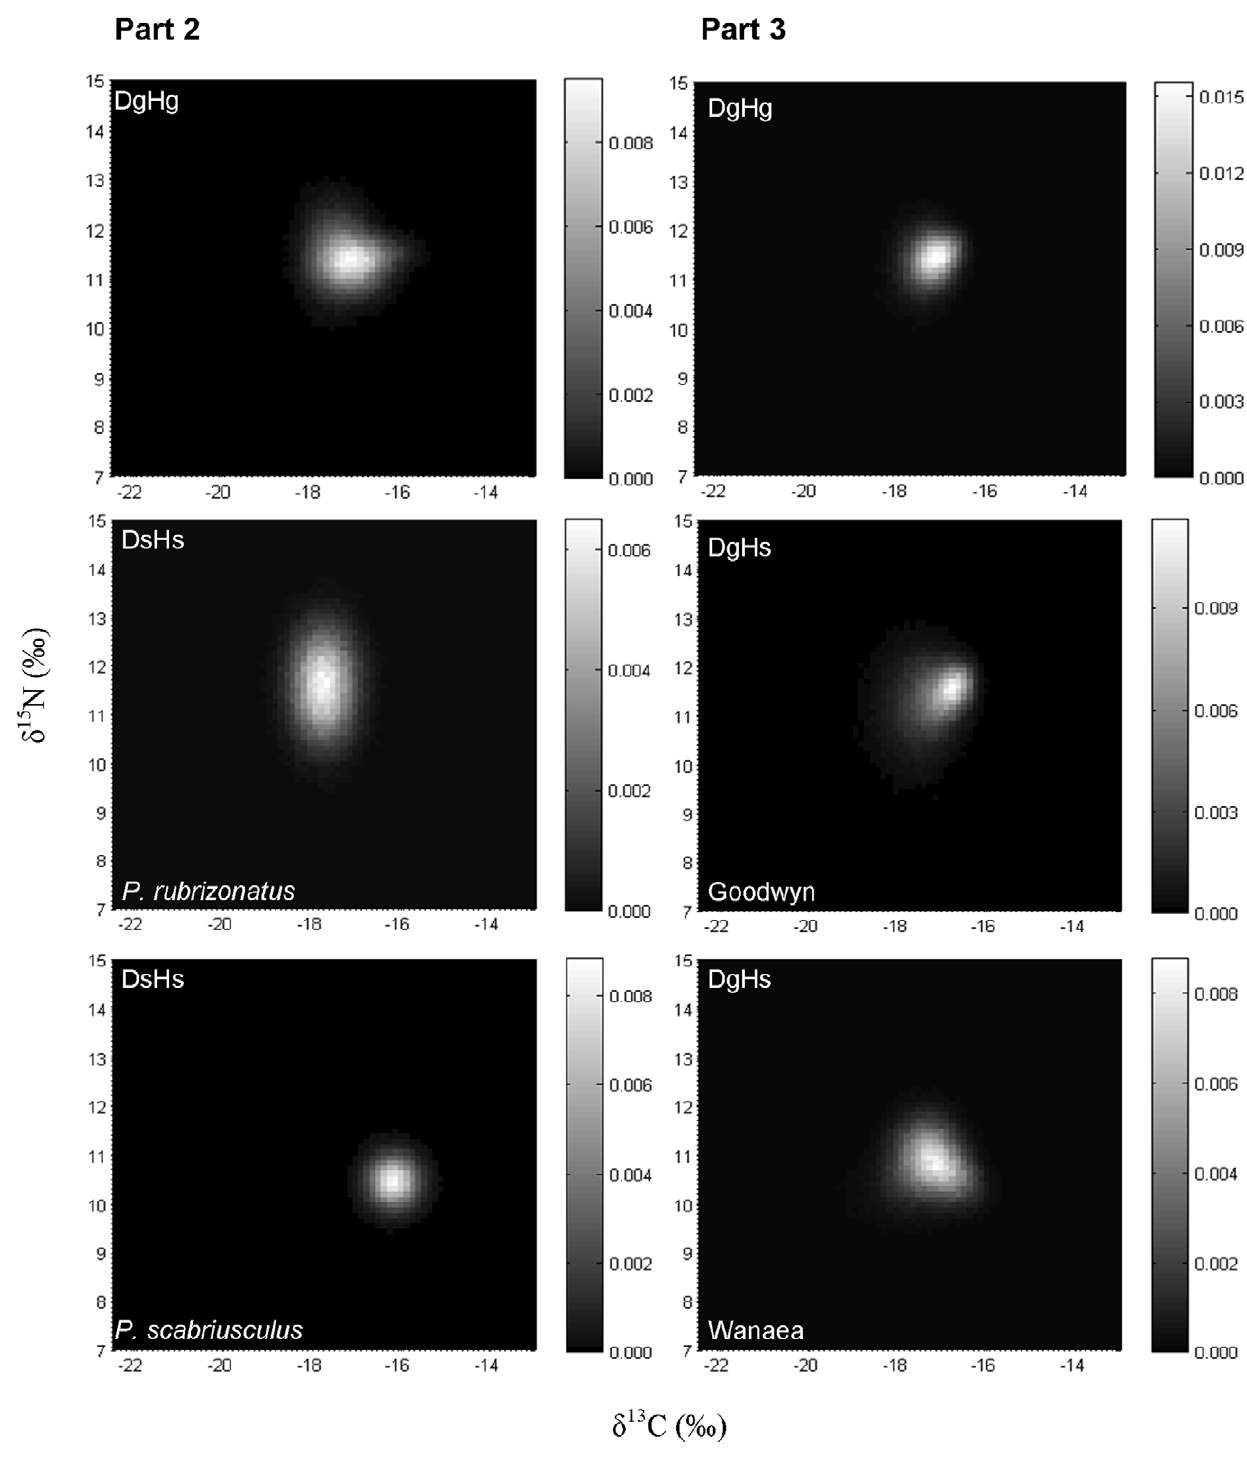
Figure 3. 2D histograms showing the distribution of the results obtained for 100 000 of the isotopic signatures from the modelled Almaco Jack in d -space incorporating distance between sites for the common prey species (Part 2), and the entire prey assemblages (Part 3). Models include those for dietary generalists and habitat generalists (D g H g ), dietary specialists and habitat specialists (D s H s ) (Part 2 only) and dietary generalists and habitat specialists (D g H s ) (Part 3 only). Individual histogram greyscale bars indicate the relative frequency for each class.